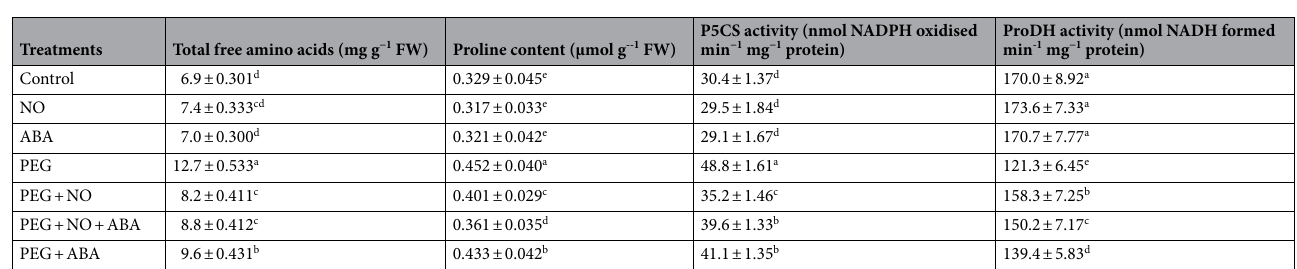
Table 2. Effect of PEG and its combination with NO and ABA (nitrate agonists) on total free amino acid, proline content, and activity of ∆ 1 -pyrroline-5-carboxylate synthetase (P5CS) and proline dehydrogenase (ProDH) of 7-days-old B. juncea L. roots after 96 h exposure to the treatments. Values are mean ± S.E. of three independent experiments, each including four biological replicates. Different letters represent significant difference between treatments, where “a” corresponds to the highest value and “d” or “e” to the lowest